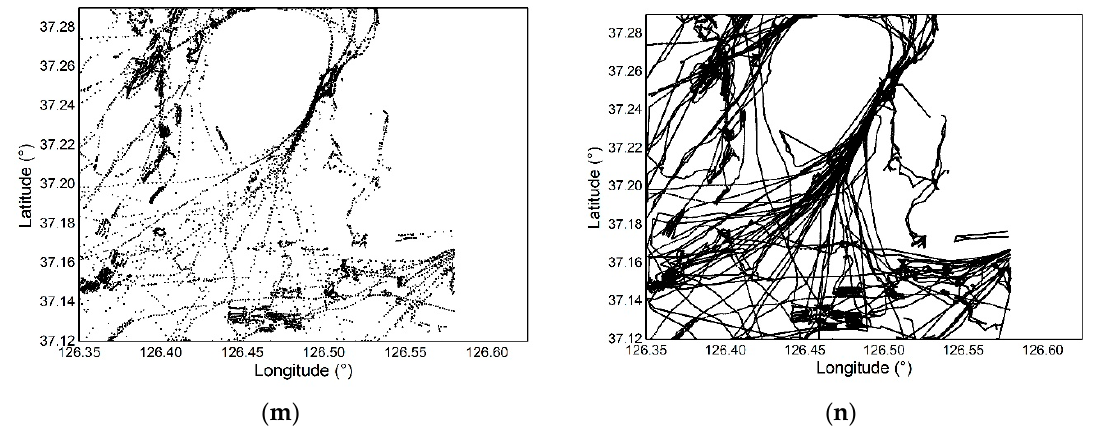
( m ) ( n ) Figure A1. ( a ) Vpass data plot on 15 May 2014; ( b ) The plot after the interpolation of Vpass data with 10 s intervals on 15 May 2014; ( c ) Vpass data plot on 16 May 2014; ( d ) The plot after the interpolation of Vpass data with 10 s intervals on 16 May 2014; ( e ) Vpass data plot on 17 May 2014; ( f ) The plot after the interpolation of Vpass data with 10 s intervals on 17 May 2014; ( g ) Vpass data plot on 18 May 2014; ( h ) The plot after the interpolation of Vpass data with 10 s intervals on 18 May 2014; ( i ) Vpass data plot on 19 May 2014; ( j ) The plot after the interpolation of Vpass data with 10 s intervals on 19 May 2014; ( k ) Vpass data plot on 20 May 2014; ( l ) The plot after the interpolation of Vpass data with 10 s intervals on 20 May 2014; ( m ) Vpass data plot on 21 May 2014; ( n ) The plot after the interpolation of Vpass data with 10 s intervals on 21 May 2014.